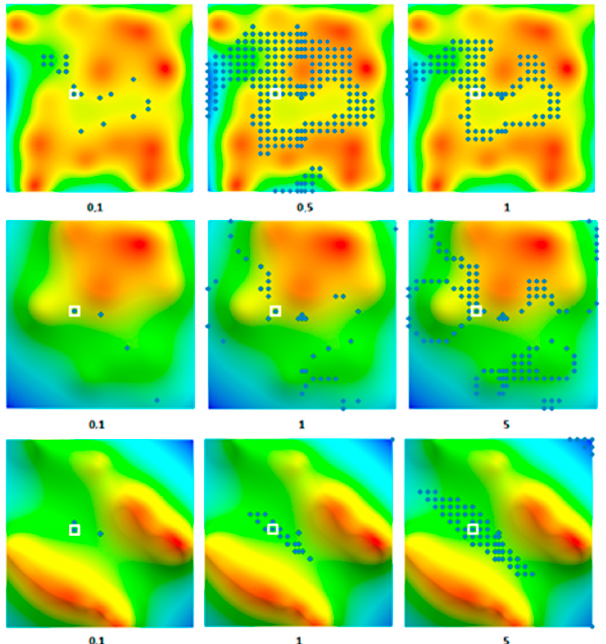
(cid:12) (cid:12) (cid:12) (cid:12) (cid:12) g (cid:12) distributions with